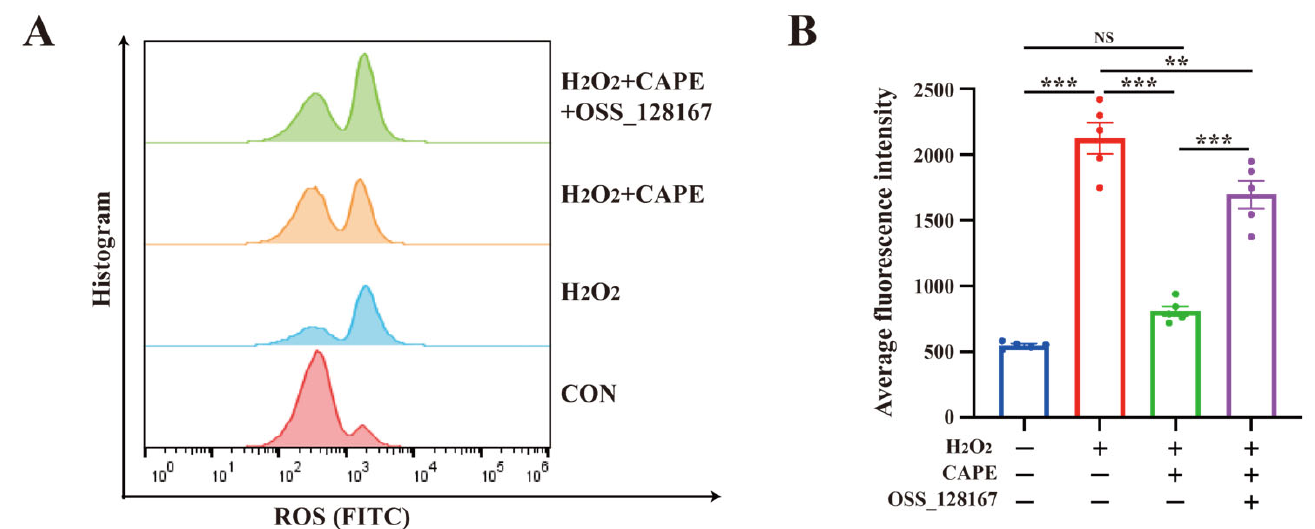
Figure 8. CAPE suppresses ROS generation through activating Sirt6 in H 2 O 2 -induced BV2 cells. ( A ) Flow cytometry analysis of ROS levels in BV2 cells under four conditions. ( B ) Average fl uorescence intensity of BV2 cells under four conditions (one-way ANOVA, p value < 0.0001; n = 5 per group). Five independent experiments were done and for each, three replicates were plated. (** p < 0.01; *** p < 0.001; NS regarded as not signi fi cant).